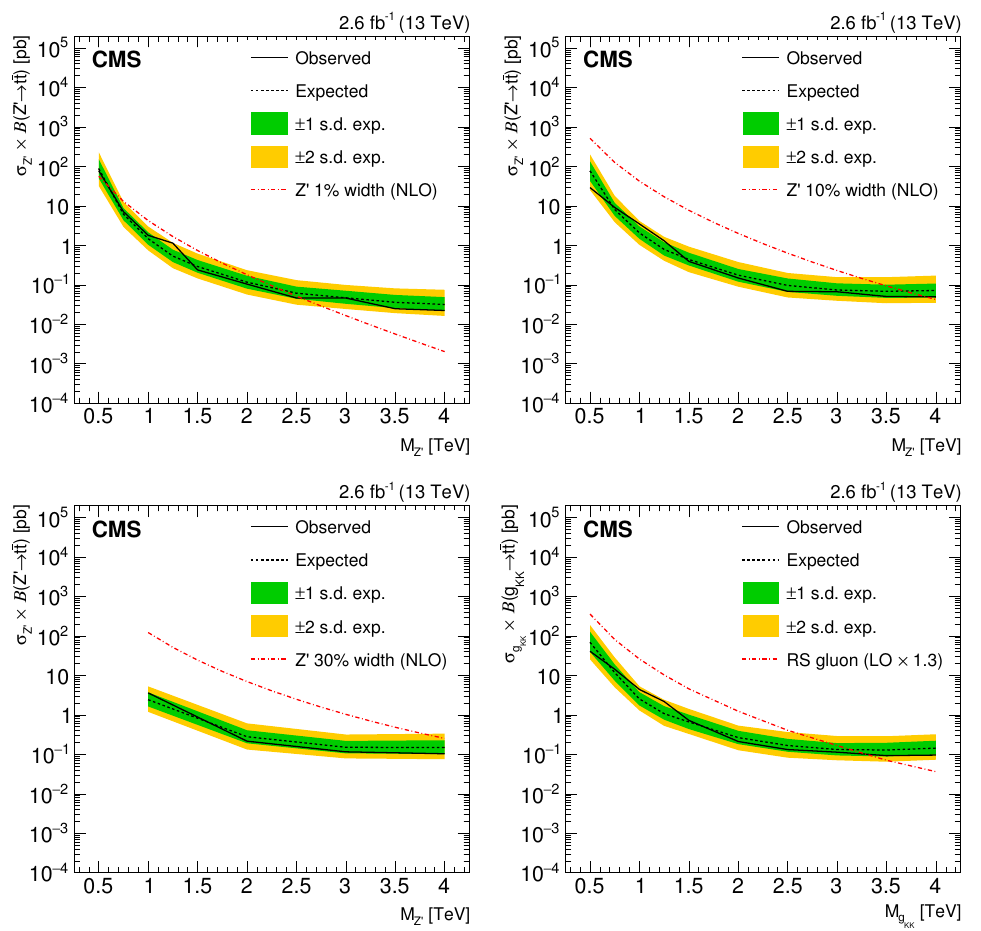
Figure 6 . Observed and expected upper limits at 95% CL on the product of the production cross section and branching fractions for the full combination of the analysis results, shown as function of the resonance mass. Limits are set using four extensions to the SM: (upper left) a Z 0 boson with (cid:0) =M of 1%, (upper right) a Z 0 boson with (cid:0) =M of 10%, (lower left) a Z 0 boson with (cid:0) =M of 30% and (lower right) a KK excitation of a gluon in the RS model. The corresponding theoretical prediction as a function of the resonance mass is shown as a dot-dashed